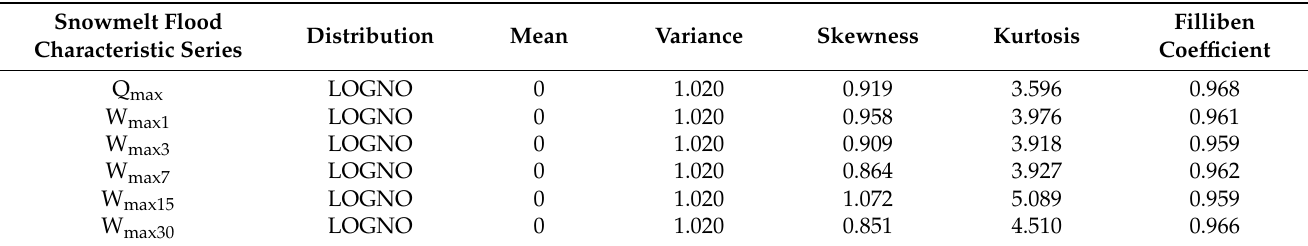
Table 4. Residual distribution moments and Filliben coefficients for optimal fitting distribution of snowmelt flood time series (model 0).